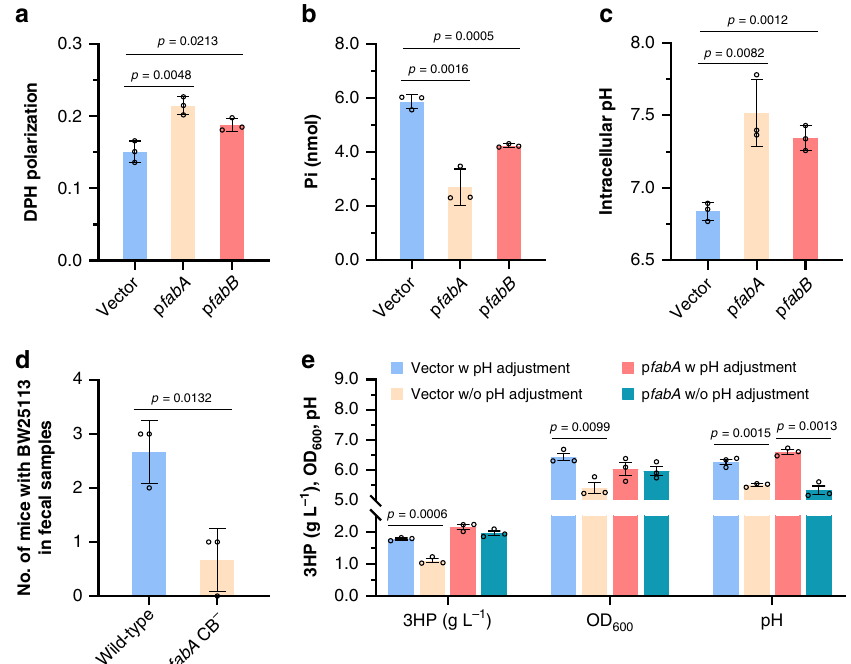
Fig. 5 The UFAs content affects membrane properties, E. coli survival in host ’ s intestine and production of organic acid. The membrane fl uidity ( a ), F 0 F 1 -ATPase activity ( b ), and intracellular pH ( c ) of BW25113 strains carrying empty vector pTrcHis2B, p fabA or p fabB , after acidic challenge at pH 4.2 for 1 h. The membrane fl uidity is determined by the anisotropy of fl uorescent probe 1,6-diphenyl-1,3,5-hexatriene (DPH). F 0 F 1 -ATPase activity is assayed in terms of the release of inorganic phosphate using permeabilized cells in ATP-containing buffer. The intracellular pH was monitored using ratiometric pH- sensitive GFP pHluorin2. d Recovery of E. coli BW25113 wild-type strain and mutant with substitution in fabA CpxR site from feces following oral administration to BALB/c mice. Three independent trials with six mice in each trail were performed for each strain. e 3-Hydroxypropionate production, OD 600 , and fi nal pH of fermentation broth of recombinant strains with and without fabA overexpression. For experiments with pH adjustment, the